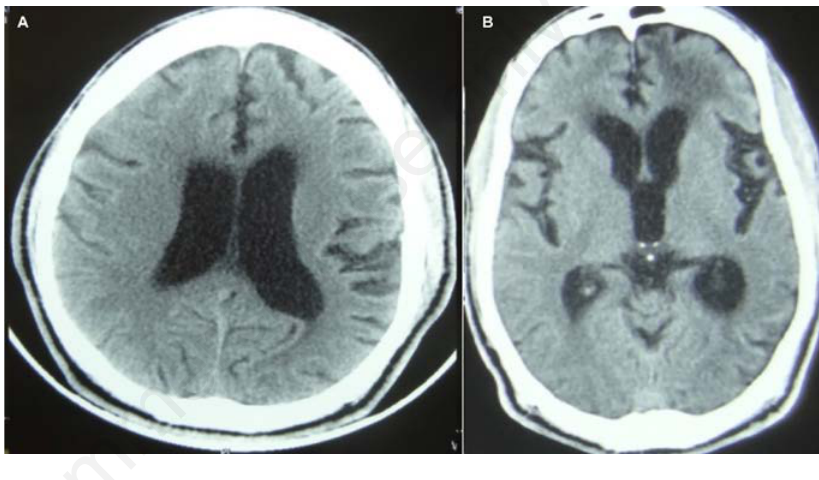
Figure 1. A) Axial non contrast computed tomography (CT) brain done five months prior to presentation showing cortical atrophy and hydrocephalus; B) axial non contrast CT brain on admission again showing hydrocephalus, with bilateral temporal atrophy, with hypodensities in the subcortical frontal region of both hemispheres, but more prominent on the left than